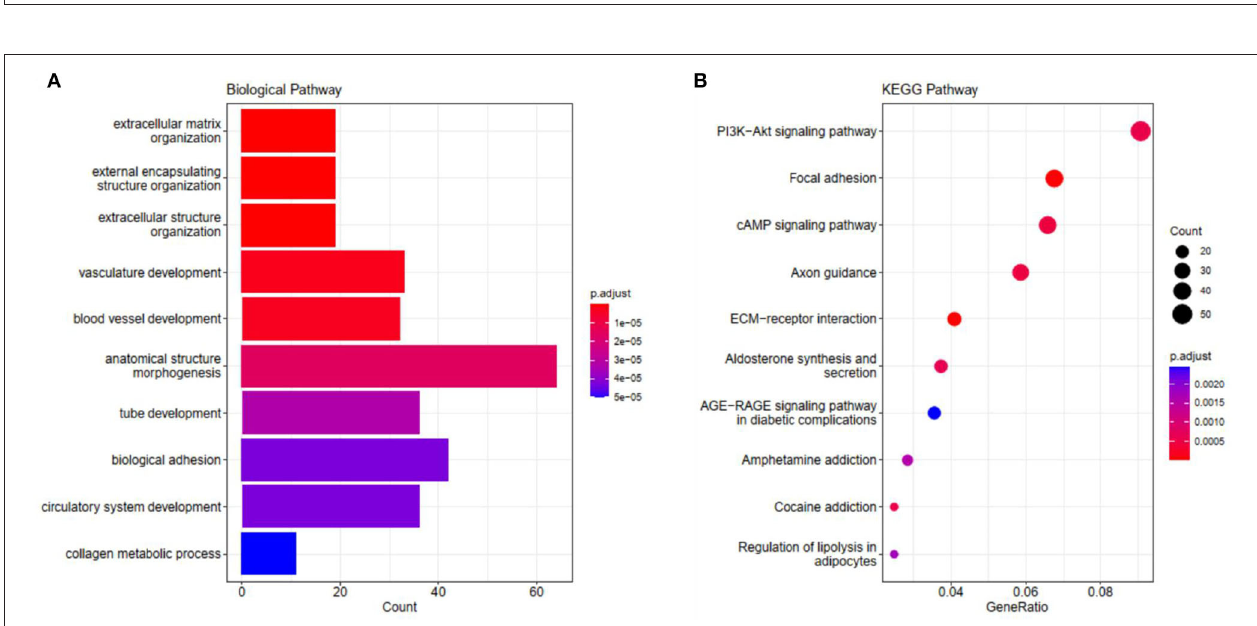
FIGURE 4 | The visualization results of (A) partial GO biological function analysis and (B) partial KEGG analysis of the blue module. The top 10 significant enriched pathways were shown.